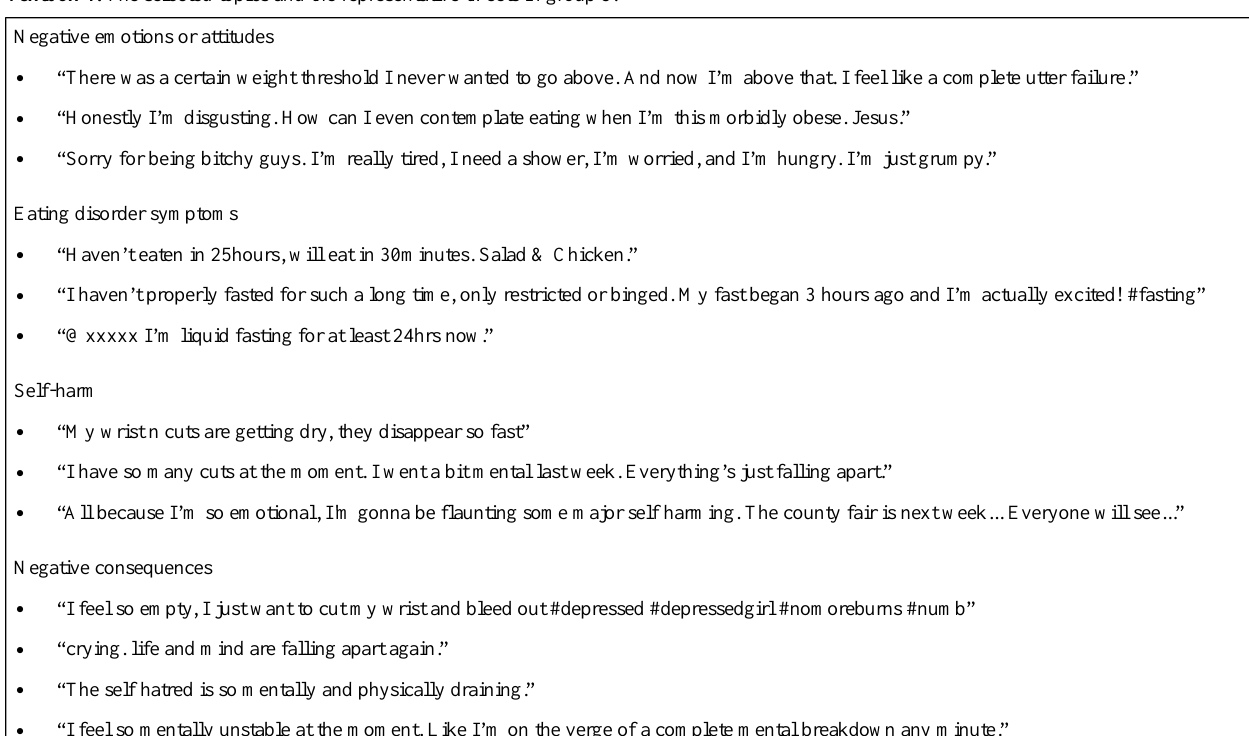
Textbox 4. The selected topics and the representative tweets in group